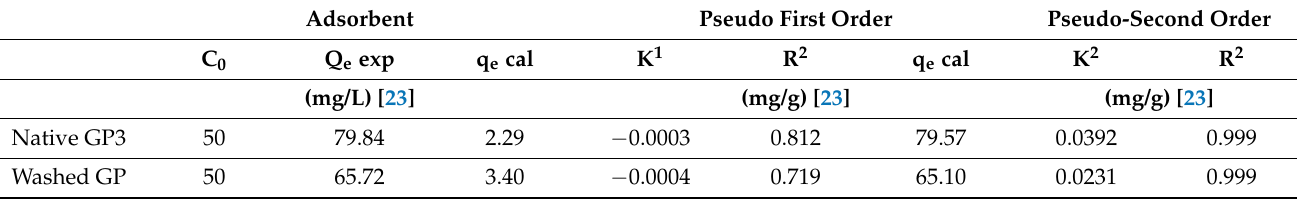
Table 2. Adsorption kinetics parameters of EBT dye of native and washed GP.